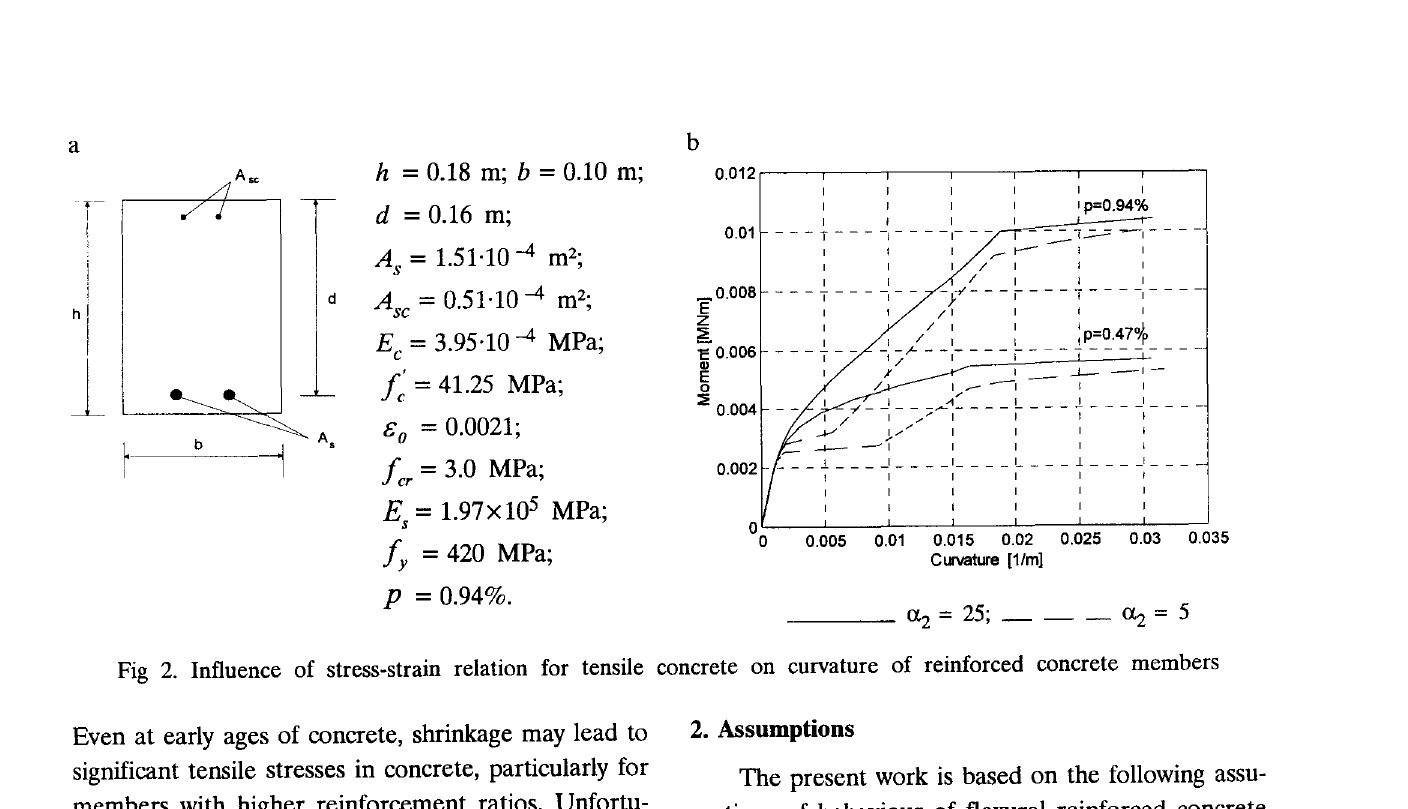
Fig 2. Influence of stress-strain relation for tensile concrete on curvature of reinforced concrete members Even at early ages of concrete, shrinkage may lead